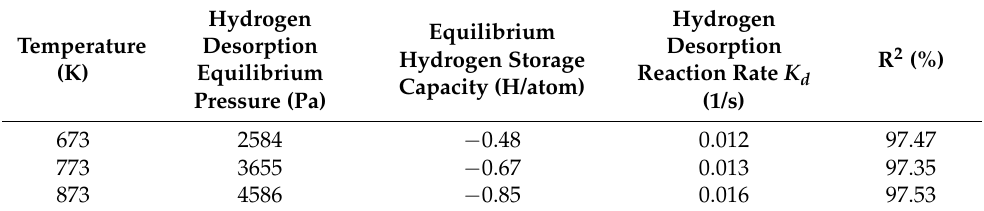
Table 4. The hydrogen desorption equilibrium pressure, equilibrium hydrogen storage capacity